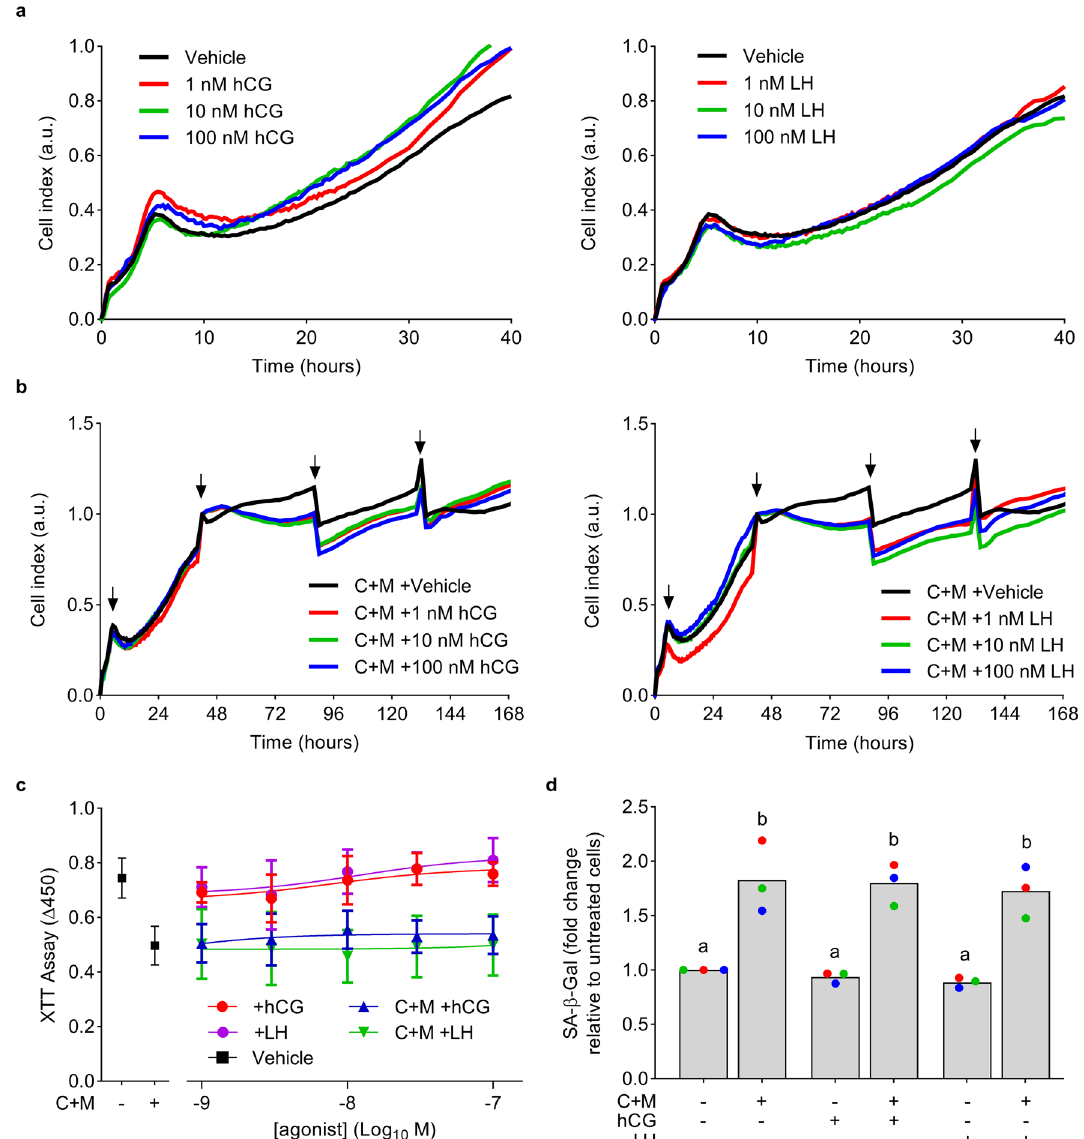
Figure 4. EnSC proliferation and viability are refractory to LHCGR ligands. ( a , b ) Impact of varying concentrations of hCG (left panels) and LH (right panels) on the proliferation of undifferentiated ( a ) or decidualizing ( b ) EnSC as quantified by xCELLigence. Traces indicate changes in impedance (cell index) from time 0. Arrows indicate media changes. Data are representative of 3 independent primary cultures, with average data non-significant by ANOVA and Dunnett’s multiple comparison test using vehicle as the comparator. ( c ) Impact of a range of concentrations of hCG and LH on cell proliferation in undifferentiated and decidualized (C + M) EnSC, as measured by XTT assay. Data are mean ± SD from 3 independent primary cultures. All concentrations of hCG and LH are non-significant via ANOVA and Dunnett’s multiple comparison test. ( d ) Effects of 10 nM hCG and LH on the induction of SA-β-Gal, a marker of cellular senescence. Data from 3 individual primary cultures are shown with different letters above the bars (mean values) indicating statistical differences ( P < 0.05) between groups (ANOVA and Dunnett’s multiple comparison